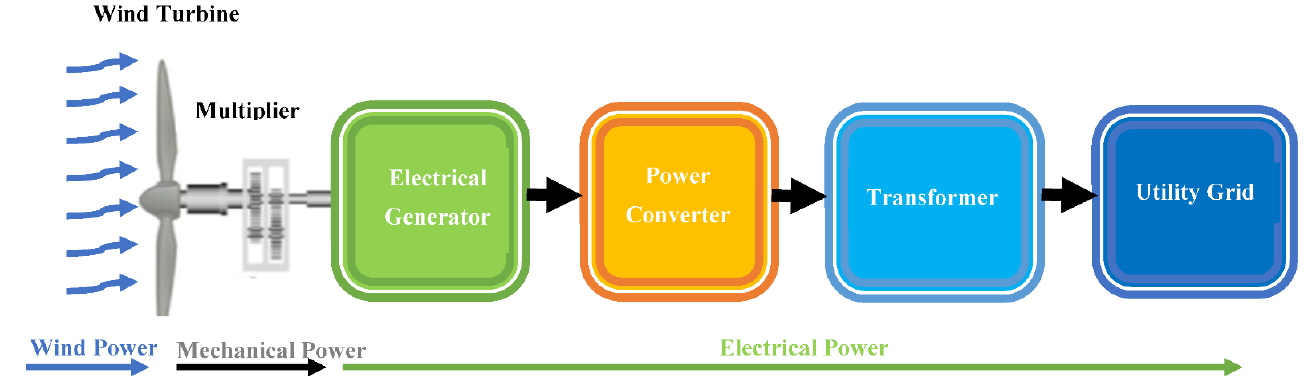
Figure 1. SRG diagram and associated converter for a wind power application.